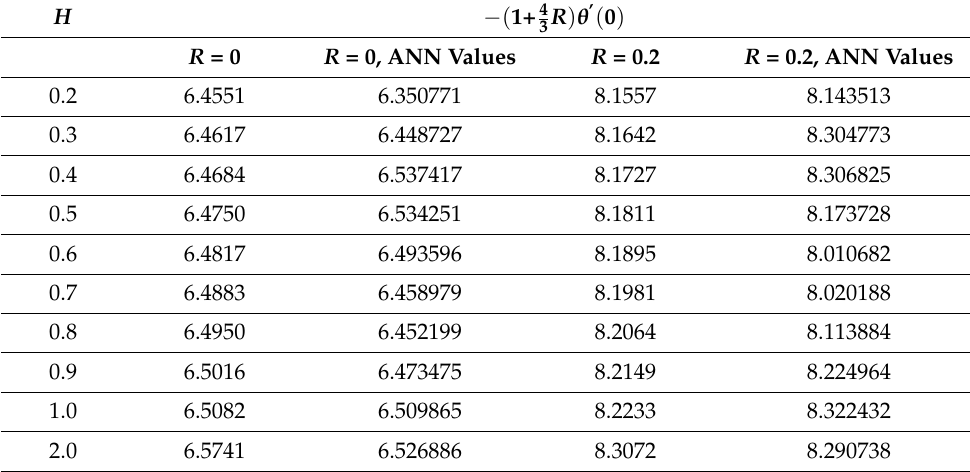
Table 10. Effect of heat generation parameter on Nusselt number for radiative and non-radiative flow fields.